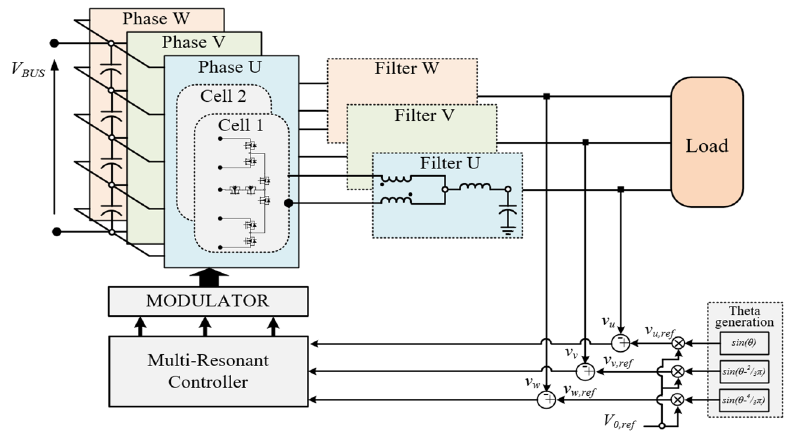
Figure 10. Block diagram of the grid-side 3 Φ 5L E-Type MMI control algorithm.